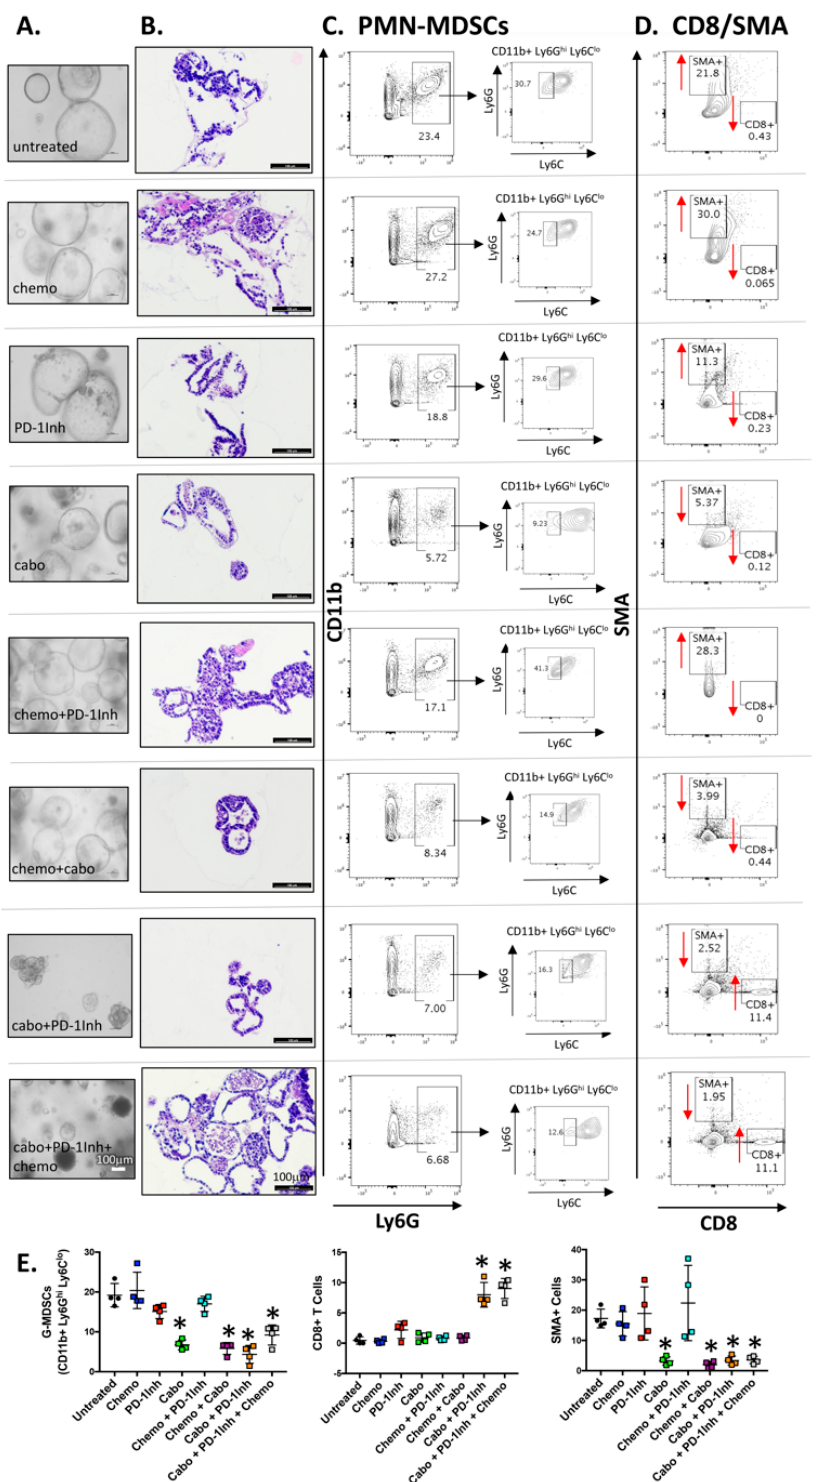
Figure 2. Changes in PMN-MDSC, CD8 and SMA cell compartments in organoids directly derived from mouse tumors in response to experimental treatments. ( A ) Light micrographs of cultured organoids and ( B ) H&E staining of embedded organoids that were derived from mouse tumors in response to experimental treatments. Flow cytometric contour plots demonstrating the changes in ( C ) PMN-MDSC, ( D ) CD8 and SMA cell populations in organoids derived from mouse tumors in response to experimental treatments. Quantification (% cell populations) is shown in ( E ). * p < 0.05 compared to untreated; n = 10 mice per group.